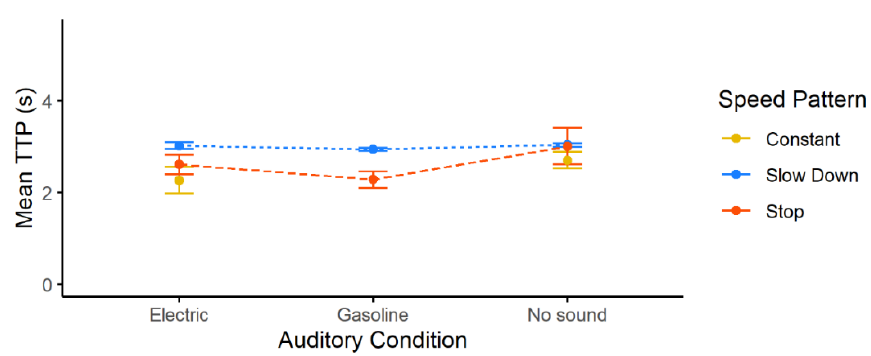
Figure 6. Mean TTP and respective mean standard error as a function of auditory condition, per vehicle speed pattern.